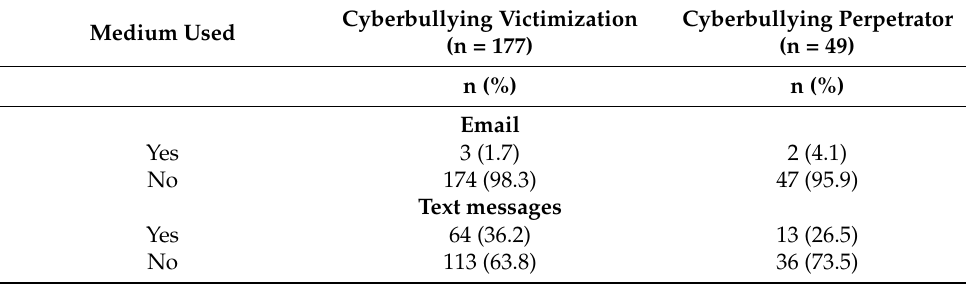
Table 3. Medium used for cyberbullying victimization and